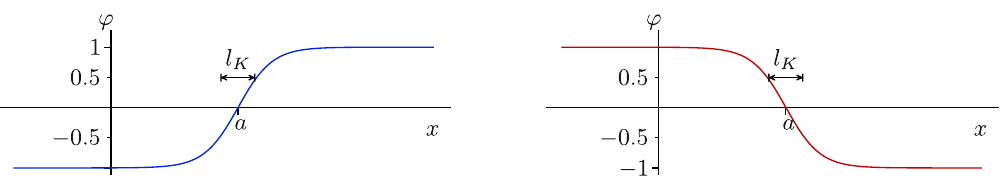
Figure 2.2: The kink (left) and antikink (right) configurations of Eq. (2.9). The characteristic width of the kink, l